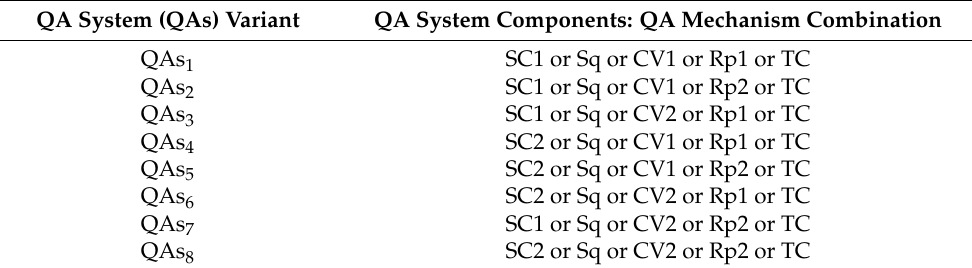
Table 3. QA system variants applied for air pollution symptom mapping